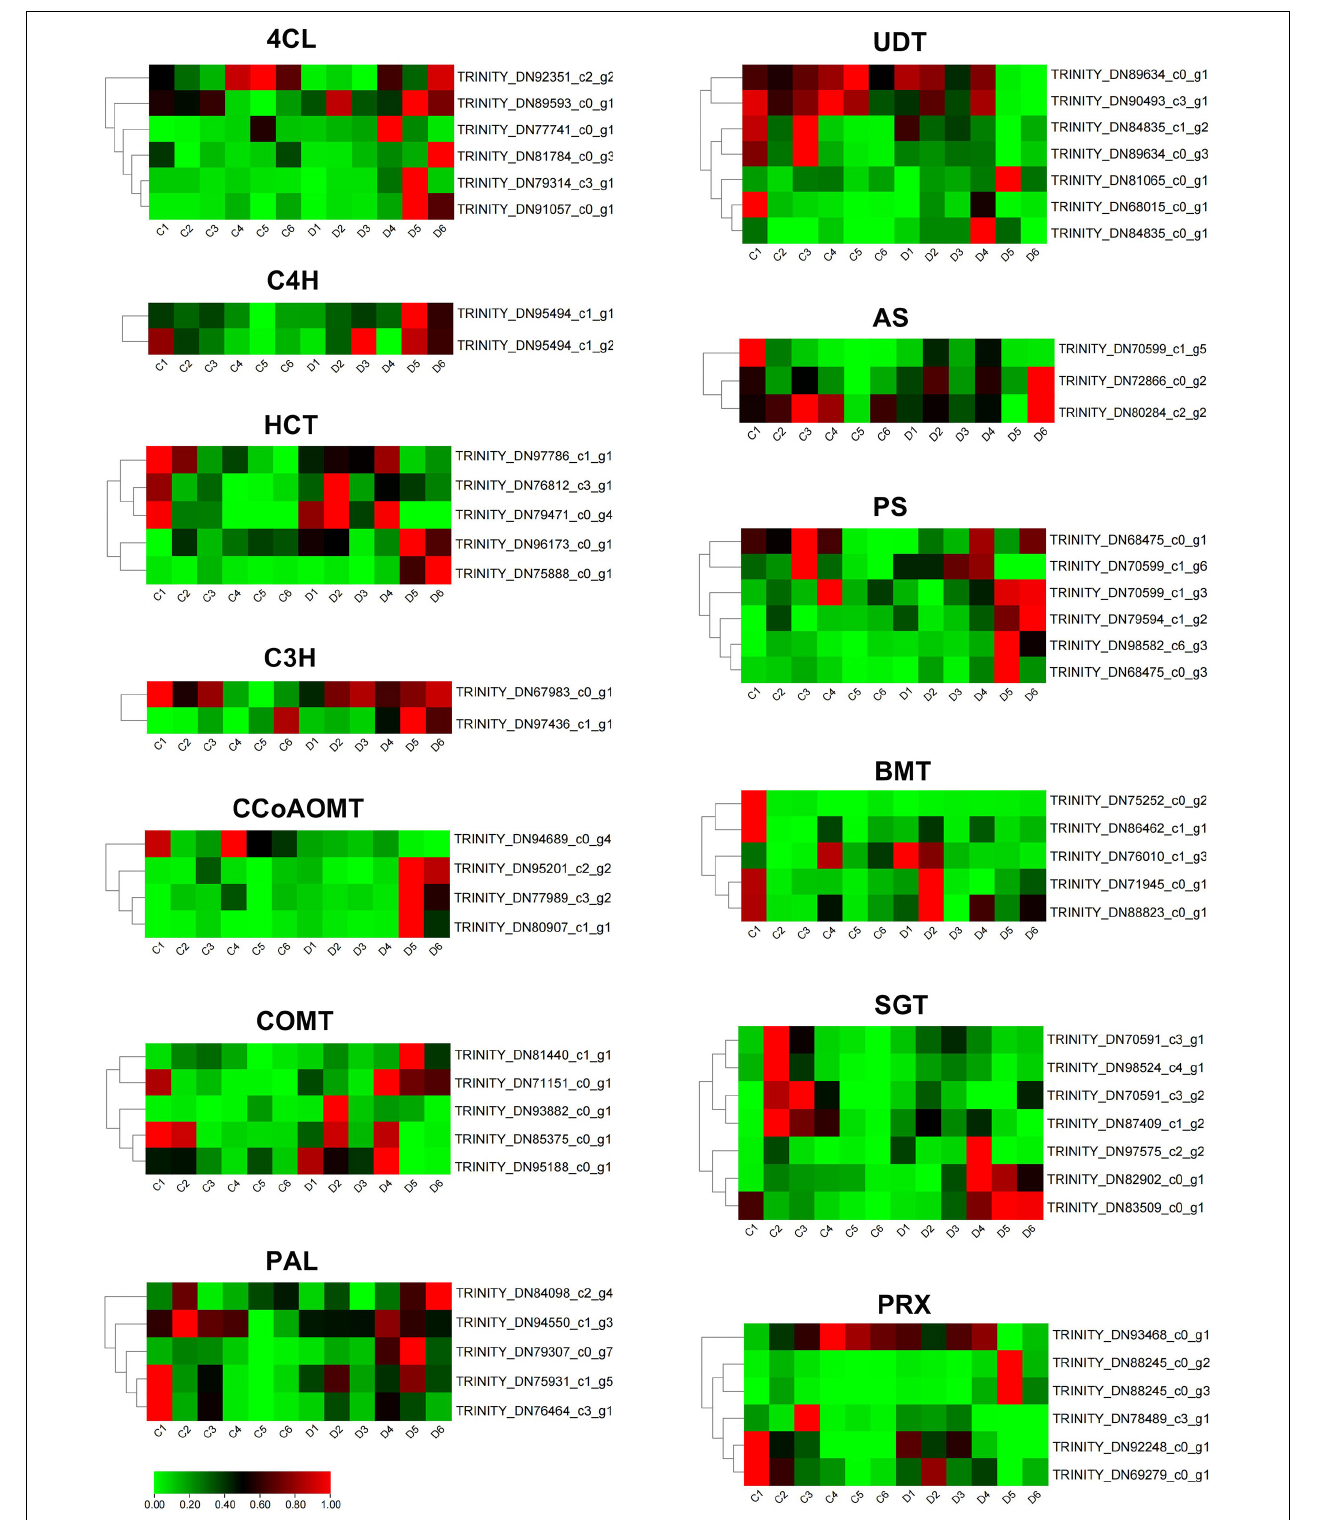
FIGURE 5 | The expression profiles of coumarin biosynthetic genes of the unbolted and bolted P. praeruptorum . TPM values were used to compare the gene expression between the two groups. These values were normalized by the log2 function. The red represents the fold change in expression levels reaching two folds, the green represents the fold change in expression levels reaching one fold, and the black represents the fold change between one and two folds.